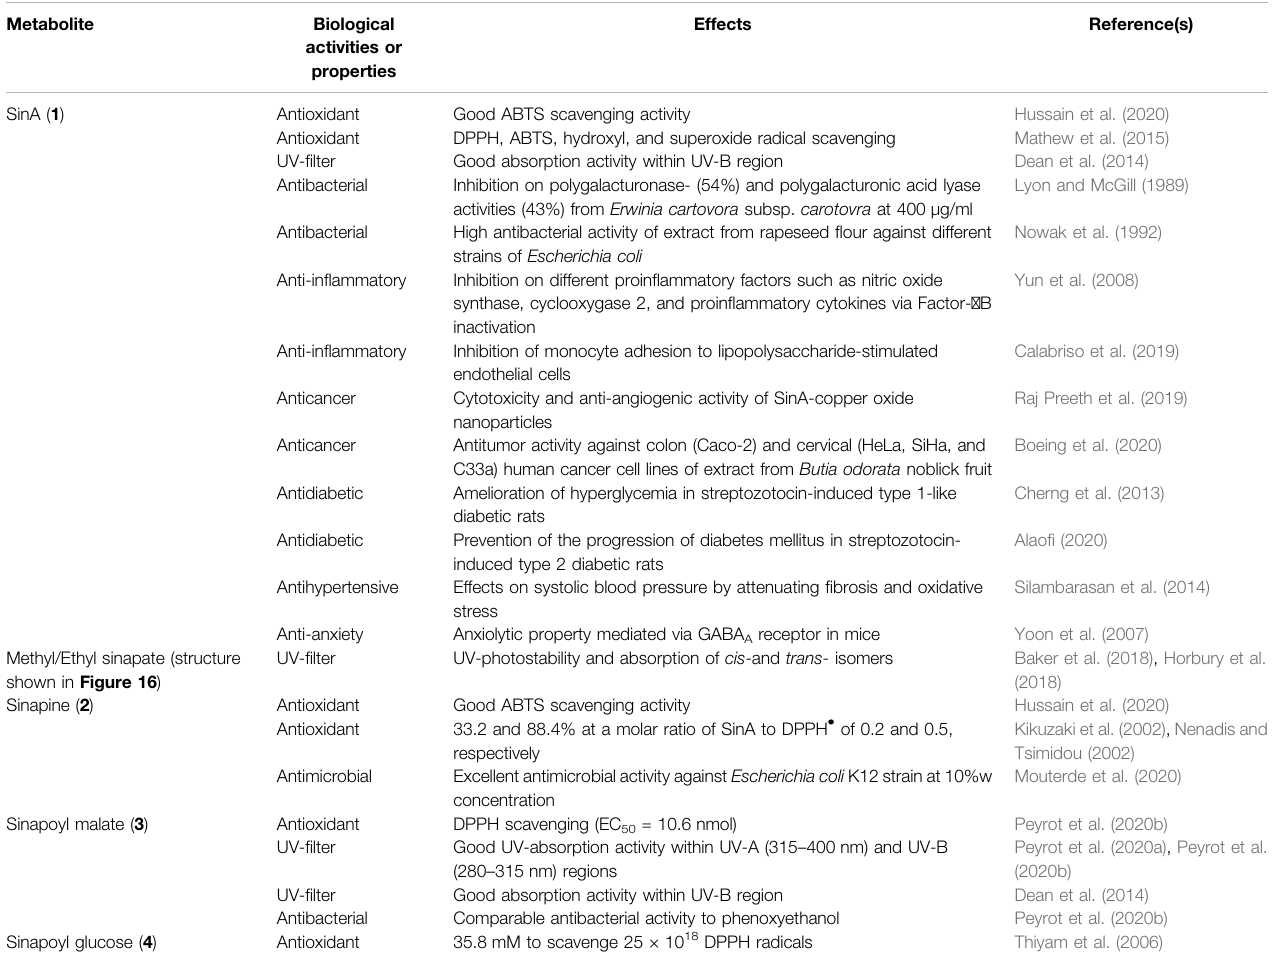
TABLE 1 | Biological activities and properties of SinA and SinEs reported in this review.